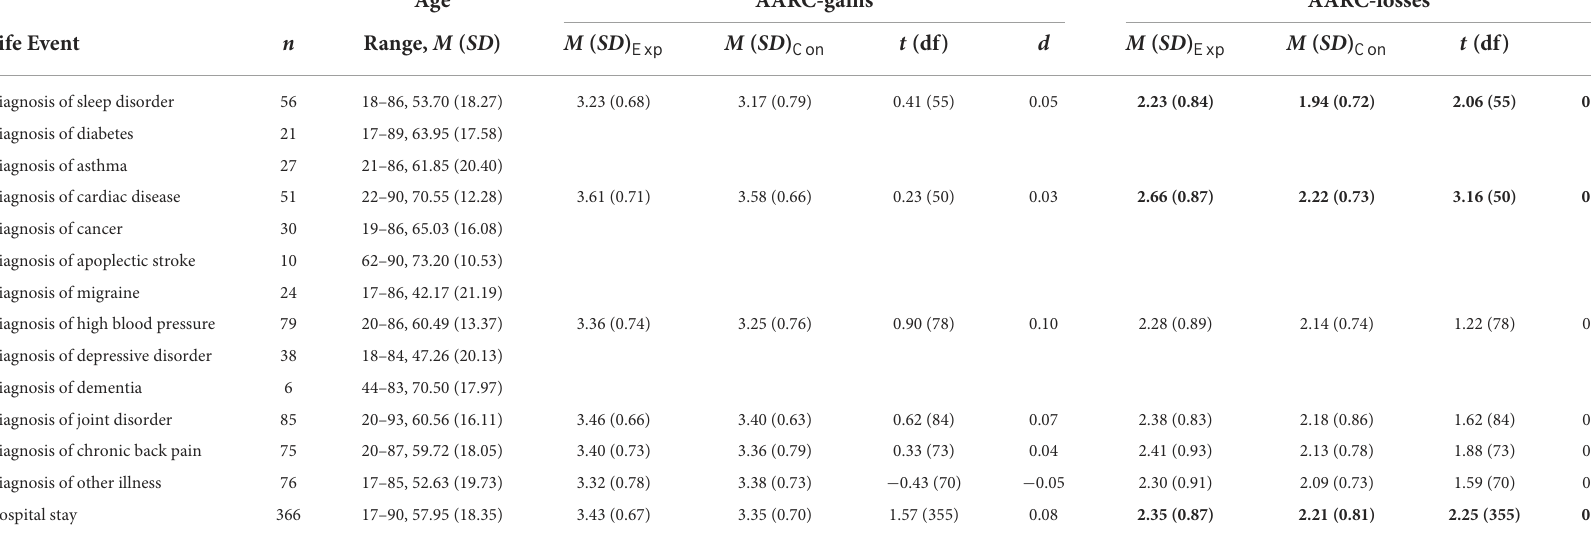
TABLE 3 Investigating the impact of specific life events in the health domain using propensity score